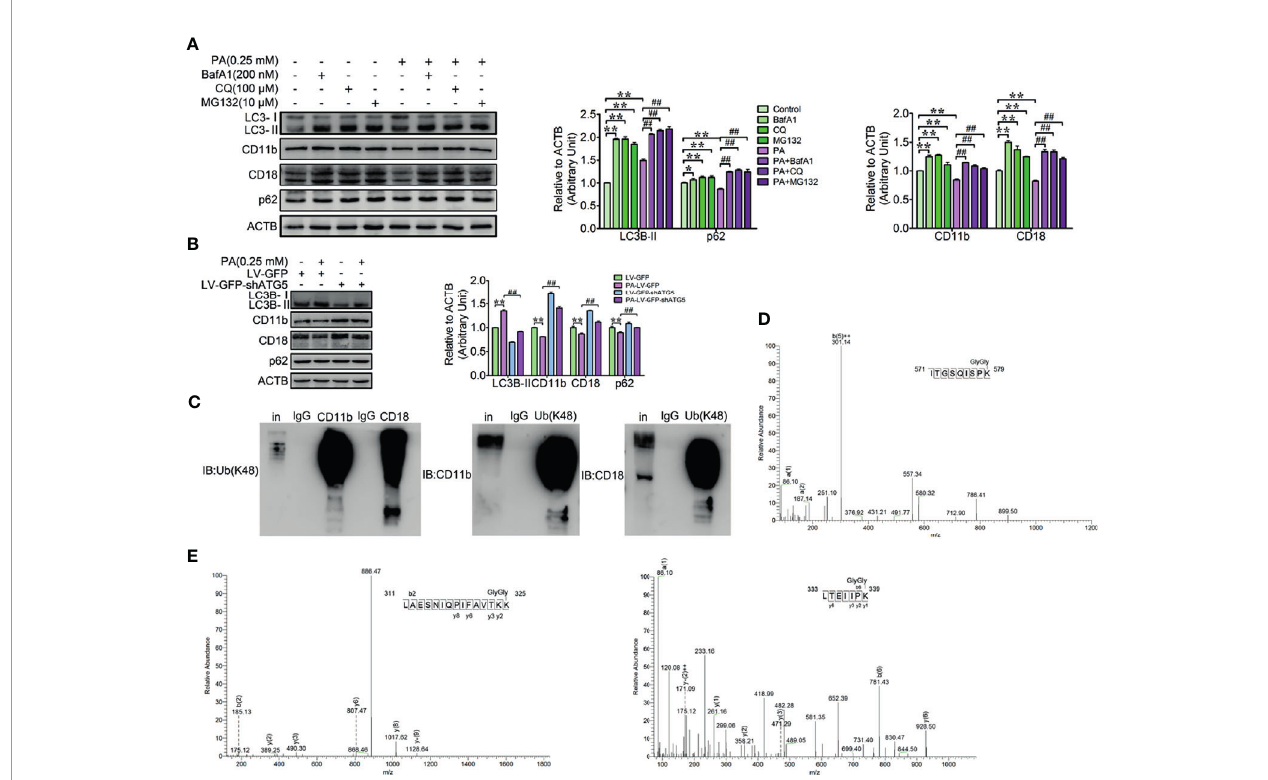
FIGURE 4 | Autophagy-mediated PA triggered the degradation of ubiquitinated CD11b and CD18 in dairy cow neutrophils. (A) Immunoblot and quantitative analysis for LC3B, p62, CD11b, and CD18 in control and PA-treated bovine neutrophils (treated or not treated with BafA1, CQ or MG132). The protein degradation was blocked by BafA1, CQ, or MG132 in control and PA-treated bovine neutrophils. Quantitative analysis of LC3B, p62, CD11b, and CD18 ( n = 3) was performed. Data represent the mean ± s.e.m. (* p < 0.05 and ** p < 0.01 versus the control group, ## p < 0.01 versus the PA-treated group; signi fi cance calculated using two-way ANOVA). (B) Immunoblot and quantitative analysis for LC3B, p62, CD11b, and CD18 in control and PA-treated dHL-60 cells (infected or not infected with LV-GFP- shATG5). Data represent mean ± s.e.m. Note: (** p < 0.01 versus the control group, ## p < 0.01 versus the PA-treated group). Data represent the mean ± s.e.m. (** p < 0.01 versus the control group, ## p < 0.01 versus the PA-treated group; signi fi cance calculated using two-way ANOVA). (C) Reciprocal co-IP of CD11b and CD18 with polyubiquitin chains (Lys48). (D) Determination of ubiquitination sites in the CD11b fragment (571-ITGSQISPK (GlyGly)-579) by MS/MS spectra. (E) Determination of ubiquitination sites in the CD18 fragments (311-LAESNIQPIFAVTKK(GlyGly)-325, 333-LTEIIPK (GlyGly)-339) by MS/MS